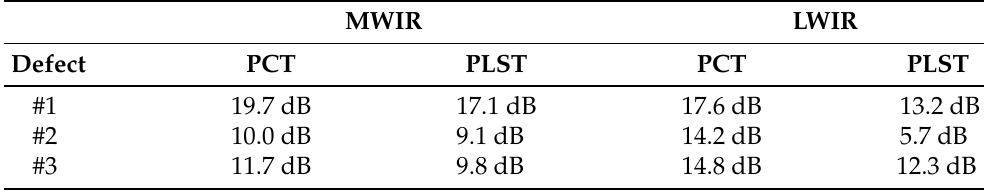
Figure 6. IR result images. In the MWIR band: ( a ) PCT 3rd EOF, and ( b ) PLST: 2nd loading. LWIR: ( c ) PCT 3rd EOF, and ( d ) PLST: 2nd loading. Table 2. SNR